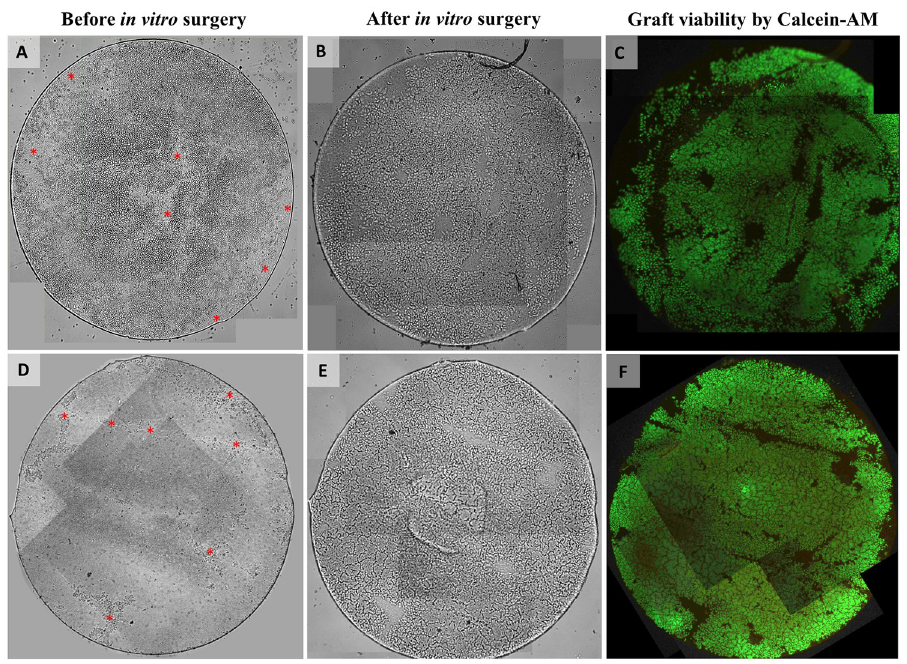
Fig 4. Light and fluorescence microscopy images of two 4mm DMEK grafts before and after in vitro surgery. (A, D) Light microscopy images of the grafts before in vitro surgery already showing some areas denuded of cells (red asterisk mark) directly after preparation which is probably related to the low-quality of the corneas ineligible for transplantation that were used for preparation. (B, E) Light microscopy images and (C, F) fluorescence microscopy images of the grafts after in vitro surgery showing again the same areas devoid of cells in addition to some other small areas on the graft that do not show any Calcein-AM fluorescence signal (indicative for the presence of viable cells). Note that one image tile each if missing in (C, F). The graft surface area within these missing image tiles was calculated (0.7% and 1.9%, respectively) and cell viability percentages were corrected for the missing graft area to avoid a potential